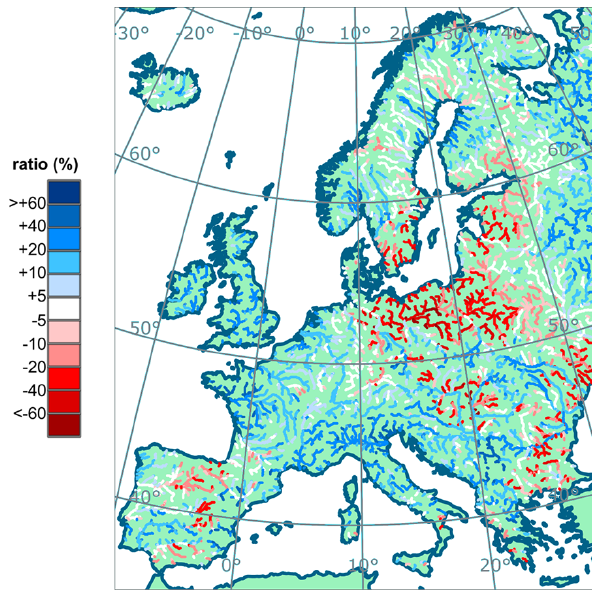
Figure 10. Example of estimated ensemble average change in the 100-year flood discharge between 2071–2100 and 1961–1990 (Rojas et al., 2012). Note that other studies are not necessarily con- sistent with these